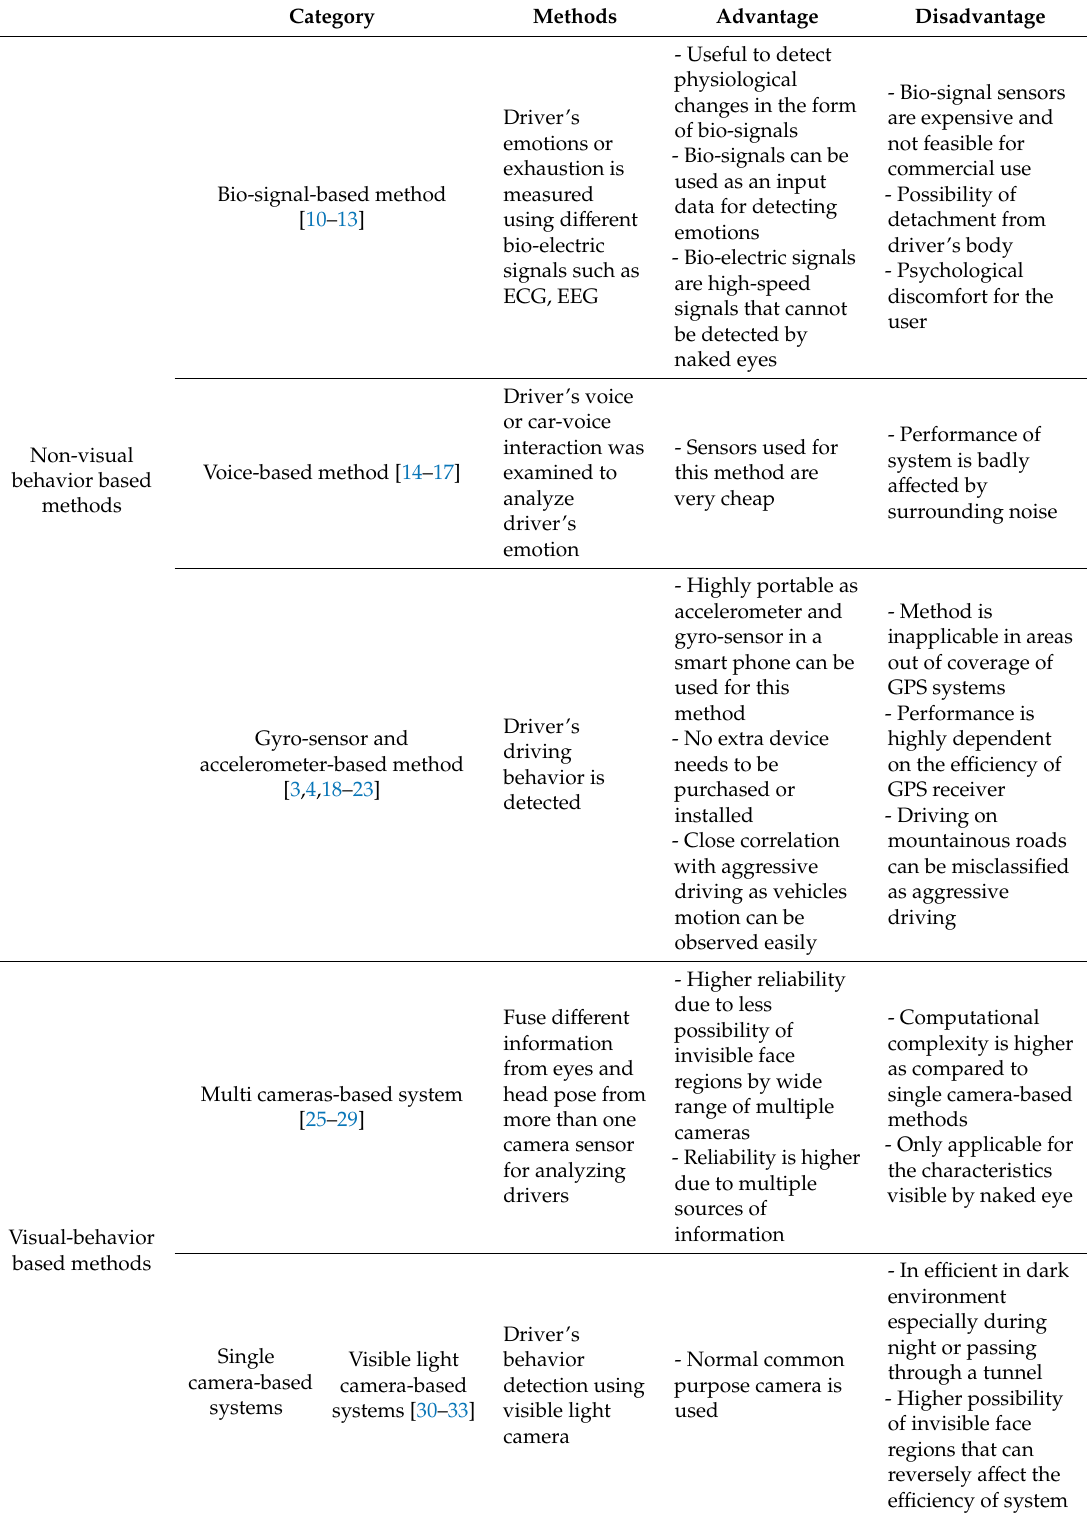
Table 1. Comparison between the proposed and previous researches on driver’s behavior